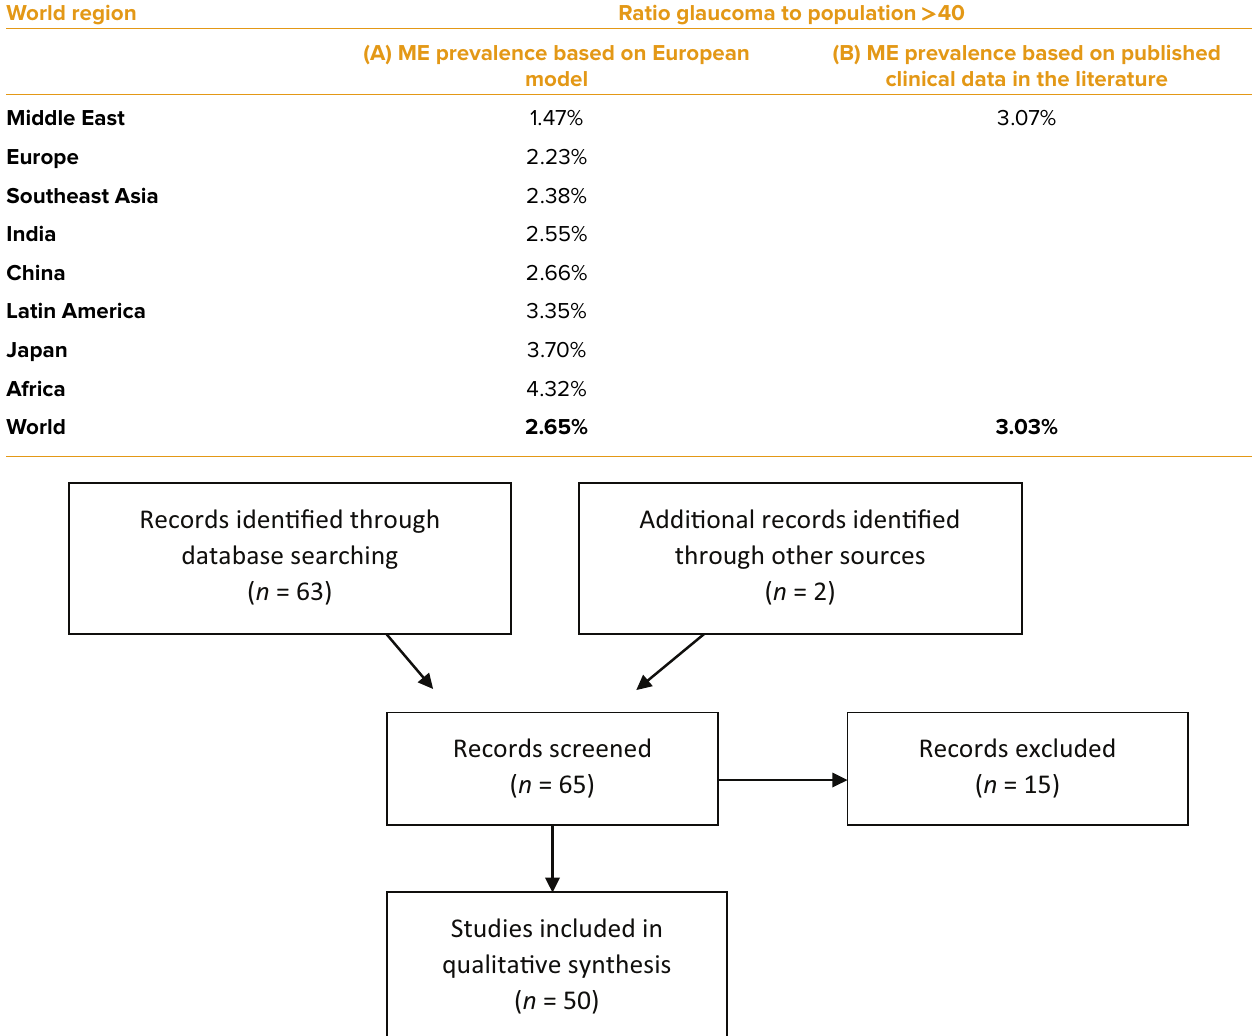
Figure 1. Flow chart showing method of literature search and results of literature